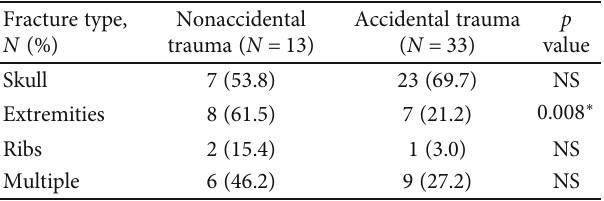
Table 3: Comparison of fracture cases for NAT and AT.